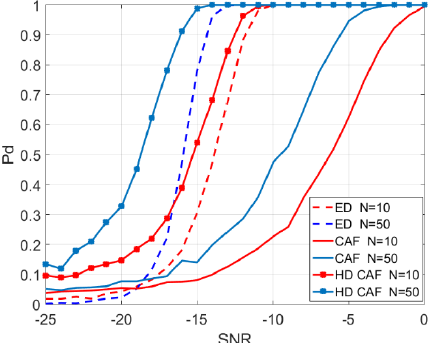
Figure 5. The probability of detection in a SNR function for HD CAF (without uncertainty of spectral density of noise power estimation influence)